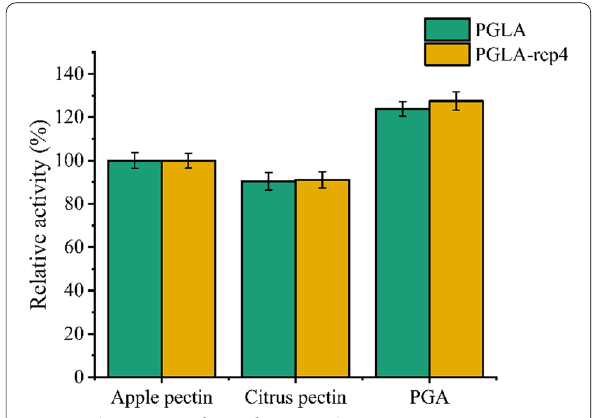
Fig. 4 Substrate specificity of PGLA and